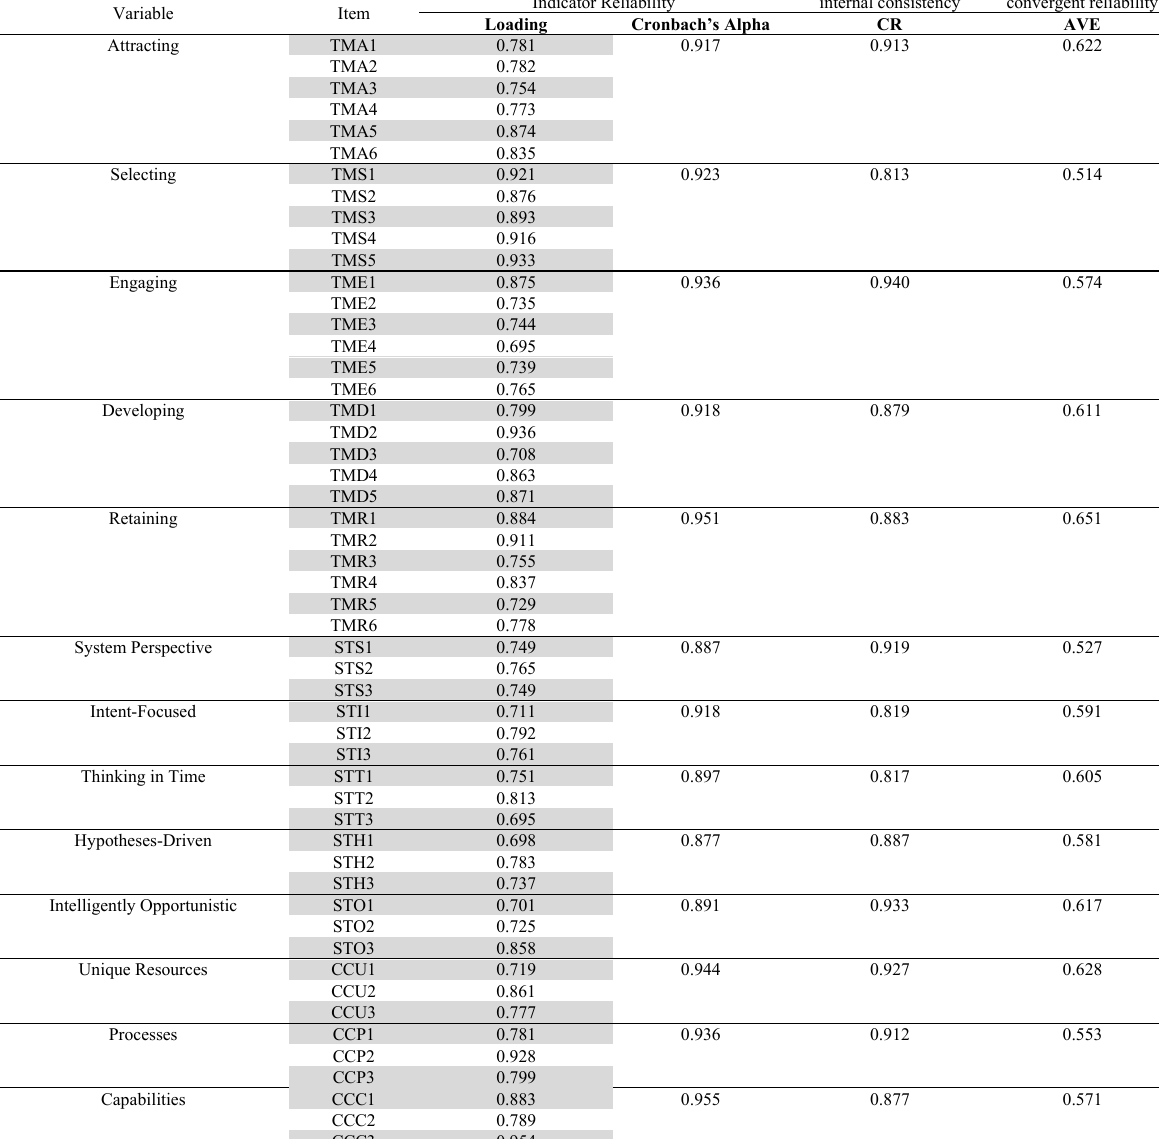
Hypothesized Model Reliability & Validity Indices’